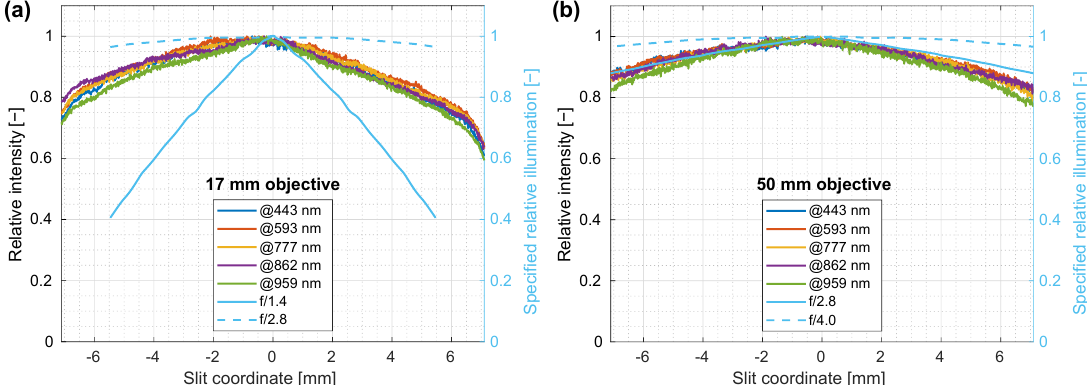
Figure 9. Spatial homogeneity of LED illumination for ( a ) 17 mm and ( b ) 50 mm objective lenses. Recorded normalized intensity is compared to the objective lens transmission specified by the manufacturer (blue color). To reduce the noise, an averaging of 30 measurements for each lens was performed.